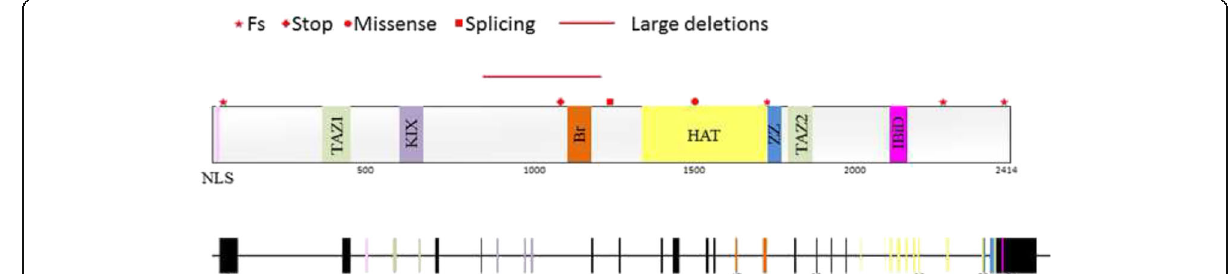
Fig. 2 Schematic representation of p300 protein and EP300 gene, including their functional and structural domains and their localization. Distribution of the variants found in EP300 gene in our cohort are showed. Symbols represent the mutation types as indicated. The different domains of the p300 protein are represented with different colours, and the exon codifying these domains are showed in the same colour: pink (NLS, nuclear localization signal), green (TAZ1, transcriptional-adaptor zinc-finger domain 1), purple (KIX, kinase inducible domain of CREB interacting domain), orange (Br, bromodomain), yellow (HAT, histone acetyltransferase domain), blue (ZZ, bromodomain), green (TAZ2, transcriptional-adaptor zinc-finger domain 2), light pink (IBiD, IRF3-binding domain). Numbers indicate aminoacid position in the protein and the exon in the